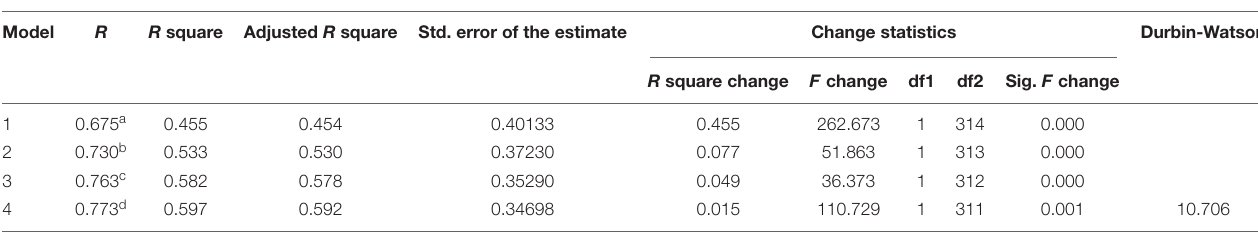
TABLE 4 | Model summary.